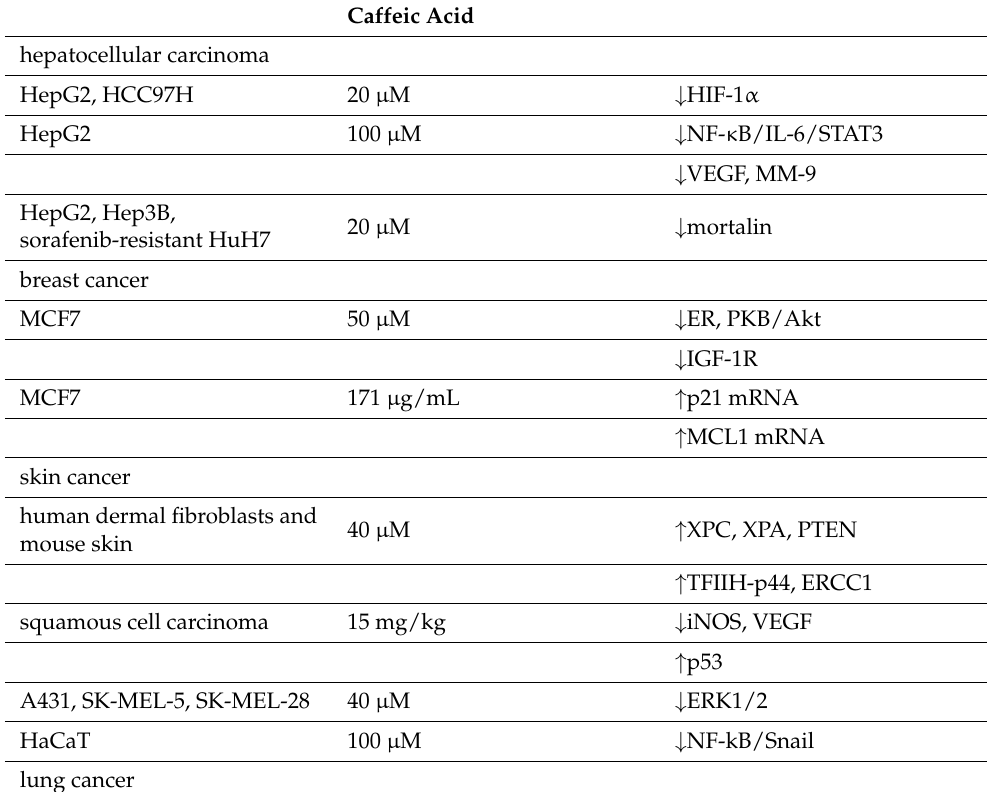
Table 1. Altered protein and mRNA expression in various types of cancer cells when exposed to caffeic